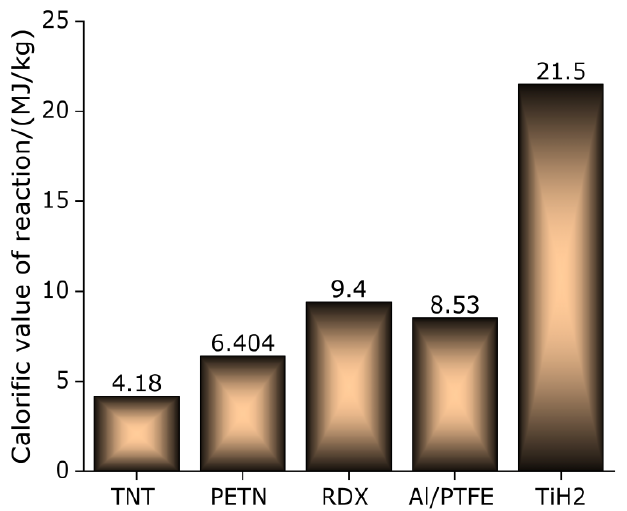
Figure 1. Plane bar chart of reaction calorific value of various materials. Recently, Yu [30,31] introduced TiH 2 into Al/PTFE energetic materials for the first time under zero oxygen balance and mainly focused on the influence of different TiH 2 content on the static mechanical properties of Al/PTFE/TiH 2 composites under an equilibrium state. By using quasi-static compression experiments, the influence rules of different